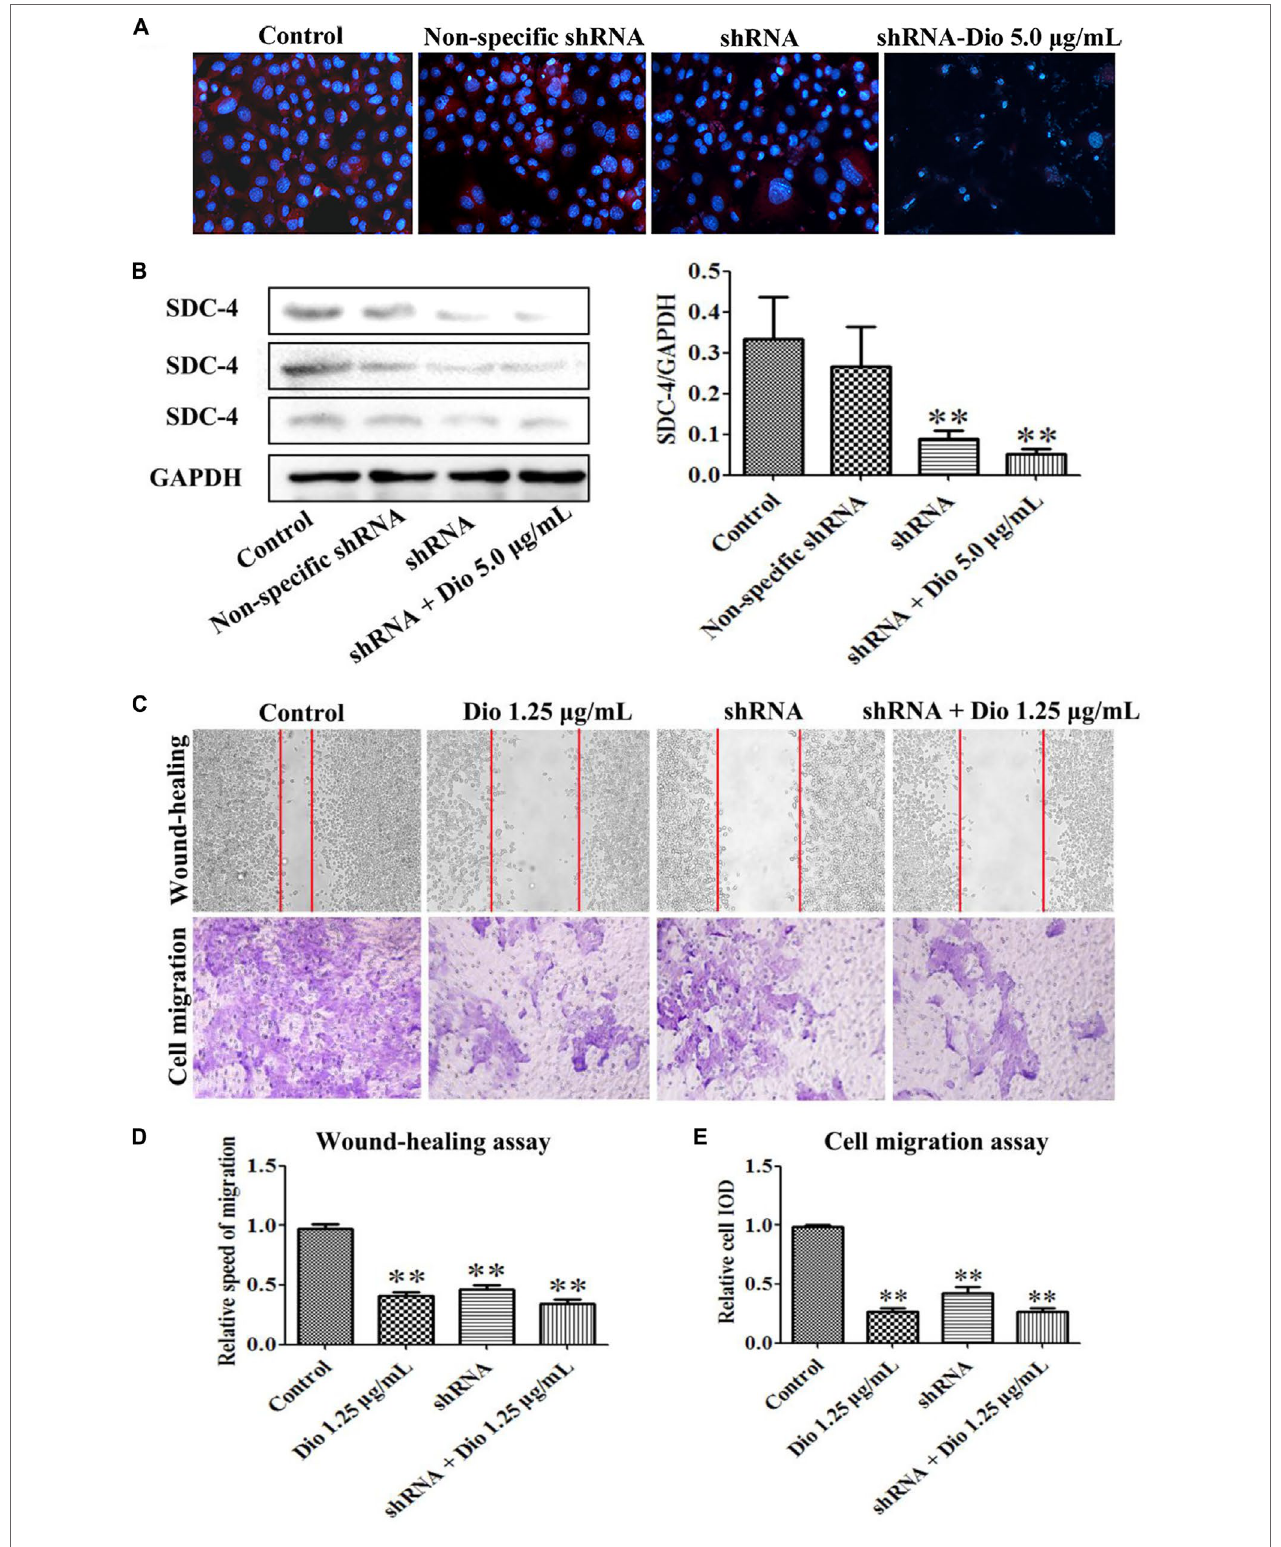
FIGURE 6 | Effects of SDC-4 shRNA and dioscin on SDC-4 expression. Effects of dioscin on SDC-4 level based on immunofluorescence assay (× 400 original magnification) (A) and western blotting assay (B) in HSC-T6 cells. (C–E) Wound-healing and cell migration assays of HSC-T6 cells treated by dioscin or SDC-4 shRNA. Data are presented as mean ± SD ( n = 3). * p < 0.05 and ** p < 0.01 compared with control